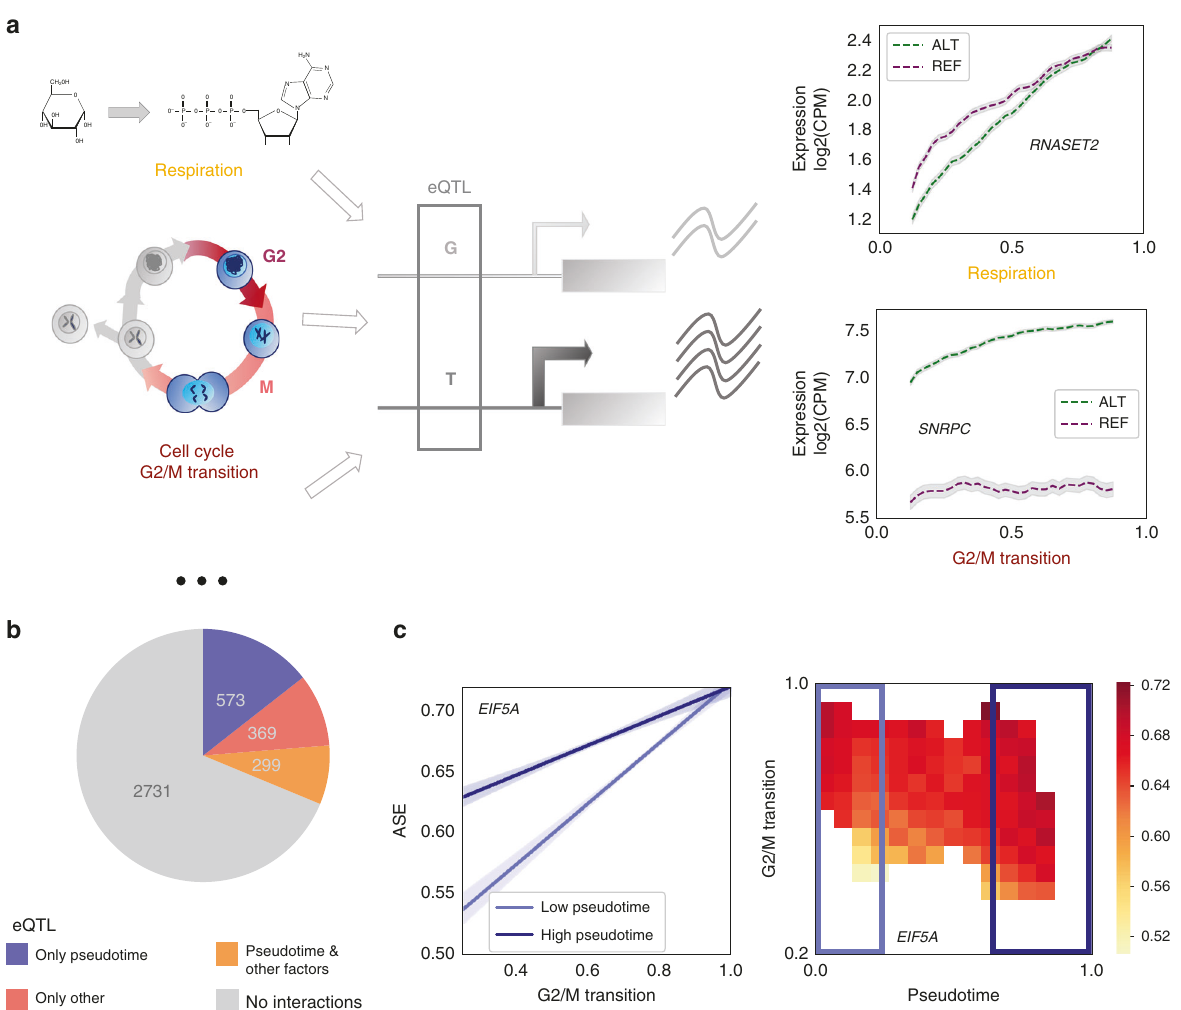
Fig. 4 Allele-speci fi c expression reveals interactions with fundamental cellular processes. a Illustration of eQTL affected by cellular context. Left: Schematic of cellular contexts affecting a regulatory element containing an eQTL SNP, and thus affecting allele-speci fi c expression. Right: Allele-speci fi c expression variation for two exemplar eQTL SNPs that tag cancer GWAS variants and display GxE interactions (FDR < 10%). The eQTL for RNASET2 ( rs2247315 ) tags a risk variant for basal cell carcinoma, and is responsive to cellular respiration, while that for SNRPC ( rs9380455 ) tags a risk variant for prostate cancer and is responsive to the cell cycle G2/M transition (Table S13). Cellular contexts for each cell were inferred by GO annotations of coexpression modules (Methods). Shaded regions indicate standard error ( + / − 1 SEM; Methods). b Results summary: numbers of eQTL (from Fig. 2; Methods) identi fi ed as displaying GxE interactions with pseudotime (purple), displaying GxE interactions with other cellular contexts but not with pseudotime, (after appropriately accounting for pseudotime, red), displaying GxE interactions with both pseudotime and at least one other cellular context (yellow), and displaying no GxE interactions at all (grey). Signi fi cance is assessed at FDR < 10%. c Higher order interaction example: an eQTL variant for EIF5A ( rs7503161 ) is affected by a GxExE higher order interaction with both pseudotime and the G1/S transition. Left panel: Effects of respiration state on ASE for cells with low and high pseudotime. Lines shown are linear regressions with 95% con fi dence intervals for the 30% of cells with lowest and highest values for pseudotime. Right panel: Heatmap of averaged ASE for cells falling within the speci fi ed windows of pseudotime and respiration state. Only values for windows containing n > 30 cells are shown ( n = 6423 cells in